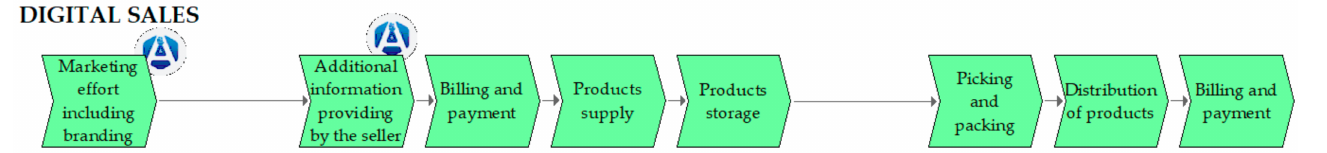
Figure 7. The sequence of phases and inclusion of a technical enabler in a digital sales channel.